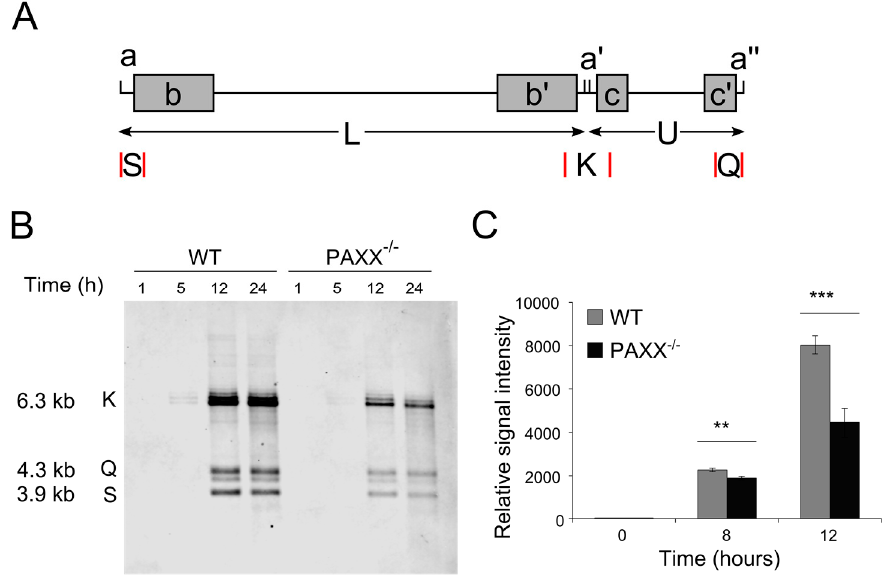
Figure 4. PAXX does not affect the proportion of endless HSV-1 genomes, but promotes genome replication. ( A ) Linear structure of the HSV-1 genome, indicating repetitive elements (a, a’, a”) and the S, K, and Q fragments created by cleavage with BamHI (selected restriction sites are denoted by red lines); ( B ) WT and PAXX − / − cells were infected at MOI 4, and total cellular and viral DNA was isolated. The HSV-1 Q, K, and S fragments were visualised by southern blot following digestion with BamHI; ( C ) WT and PAXX − / − RPE-1 cells were infected at an MOI of 4, and genome copy numbers were quantified using TaqMan qPCR. n = 3. Statistical significance, calculated by Student’s t -test, is denoted by stars—** = p < 0.02, *** = p < 0.01. n = 3. Error bars denote mean +/ − SEM.